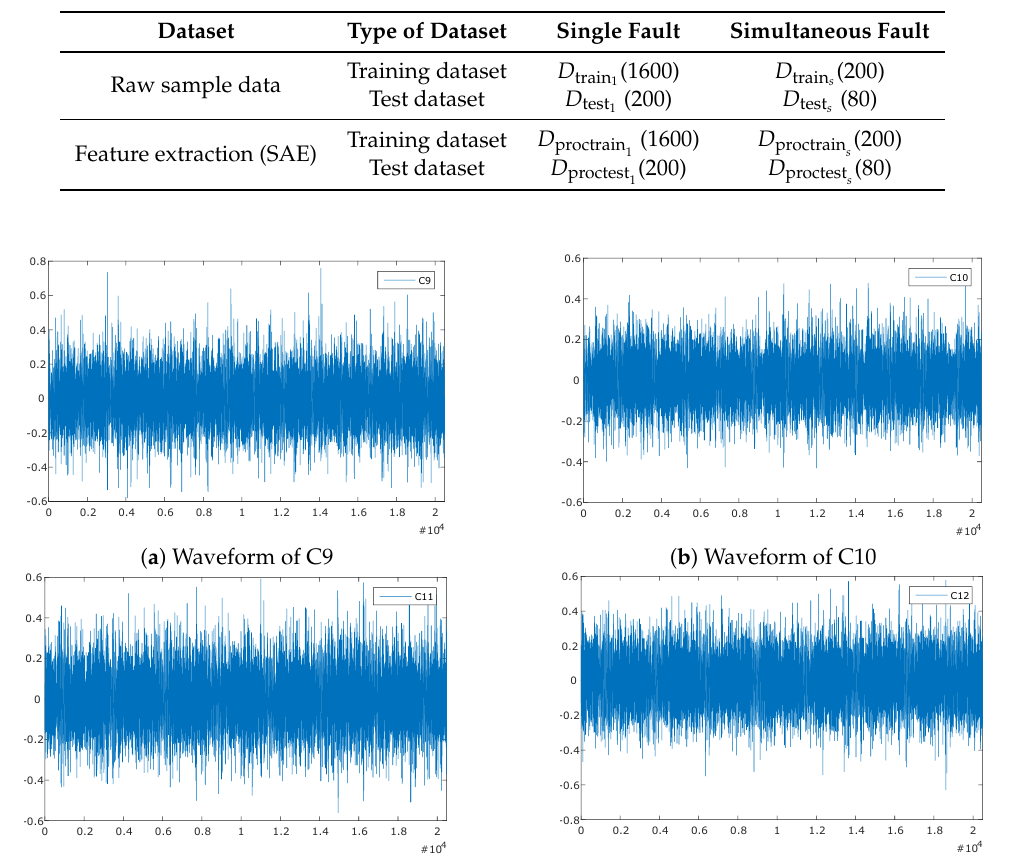
Table 3. Division of the sample dataset into different subsets.